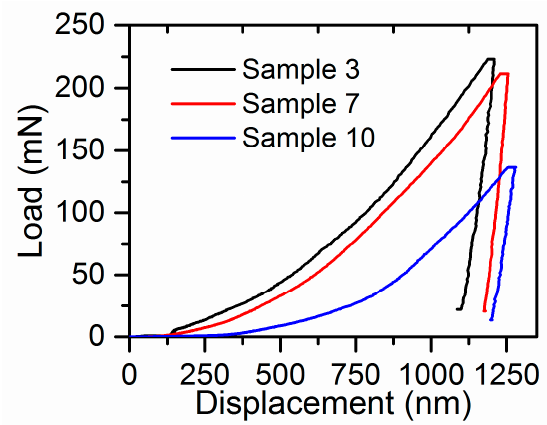
Figure 8. Representative load-displacement curves of nanoindentation tests for three samples. Table 2. Hardness and elastic modulus of nc-Ni coatings deposited under different process conditions.